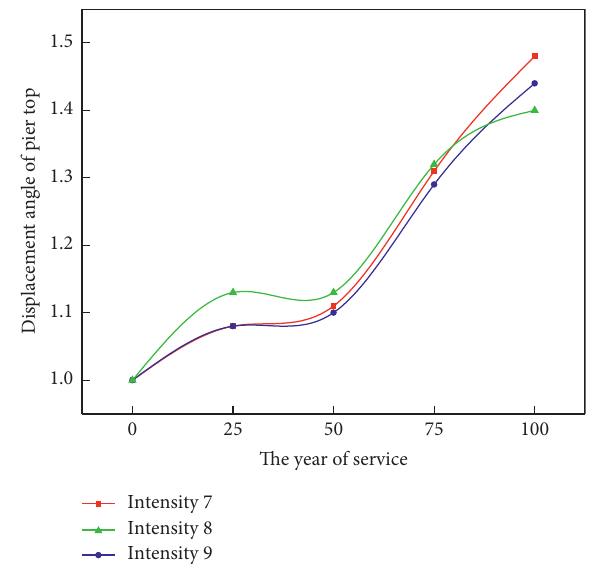
Figure 3: Influence of service life on displacement angle of bridge pier